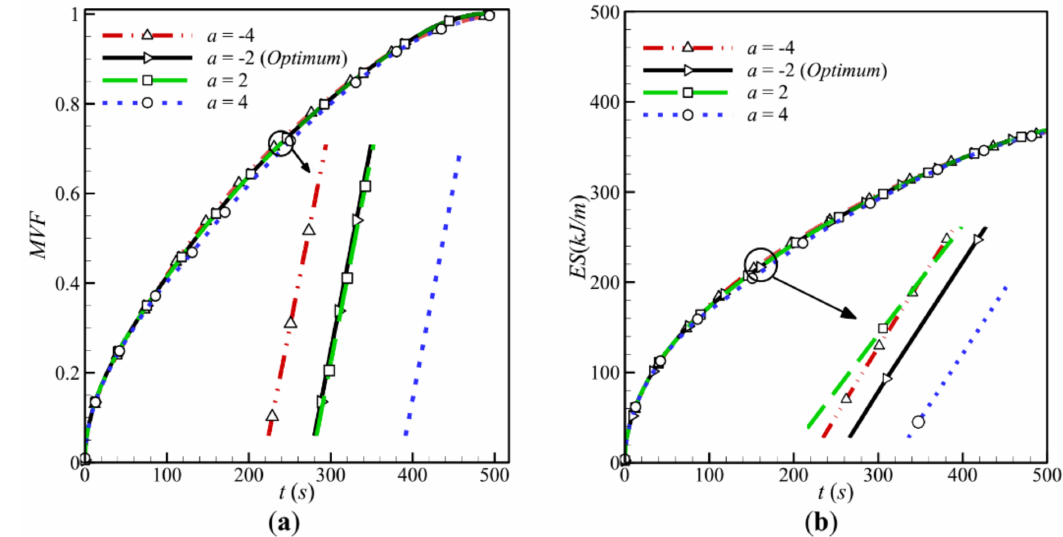
Figure 10. The effect of various porosity parameters ( a ) on the melting volume fraction and ( b ) energy stored when VF na = 0.01, ε = 0.800, γ = 2 π /4, and PPI =